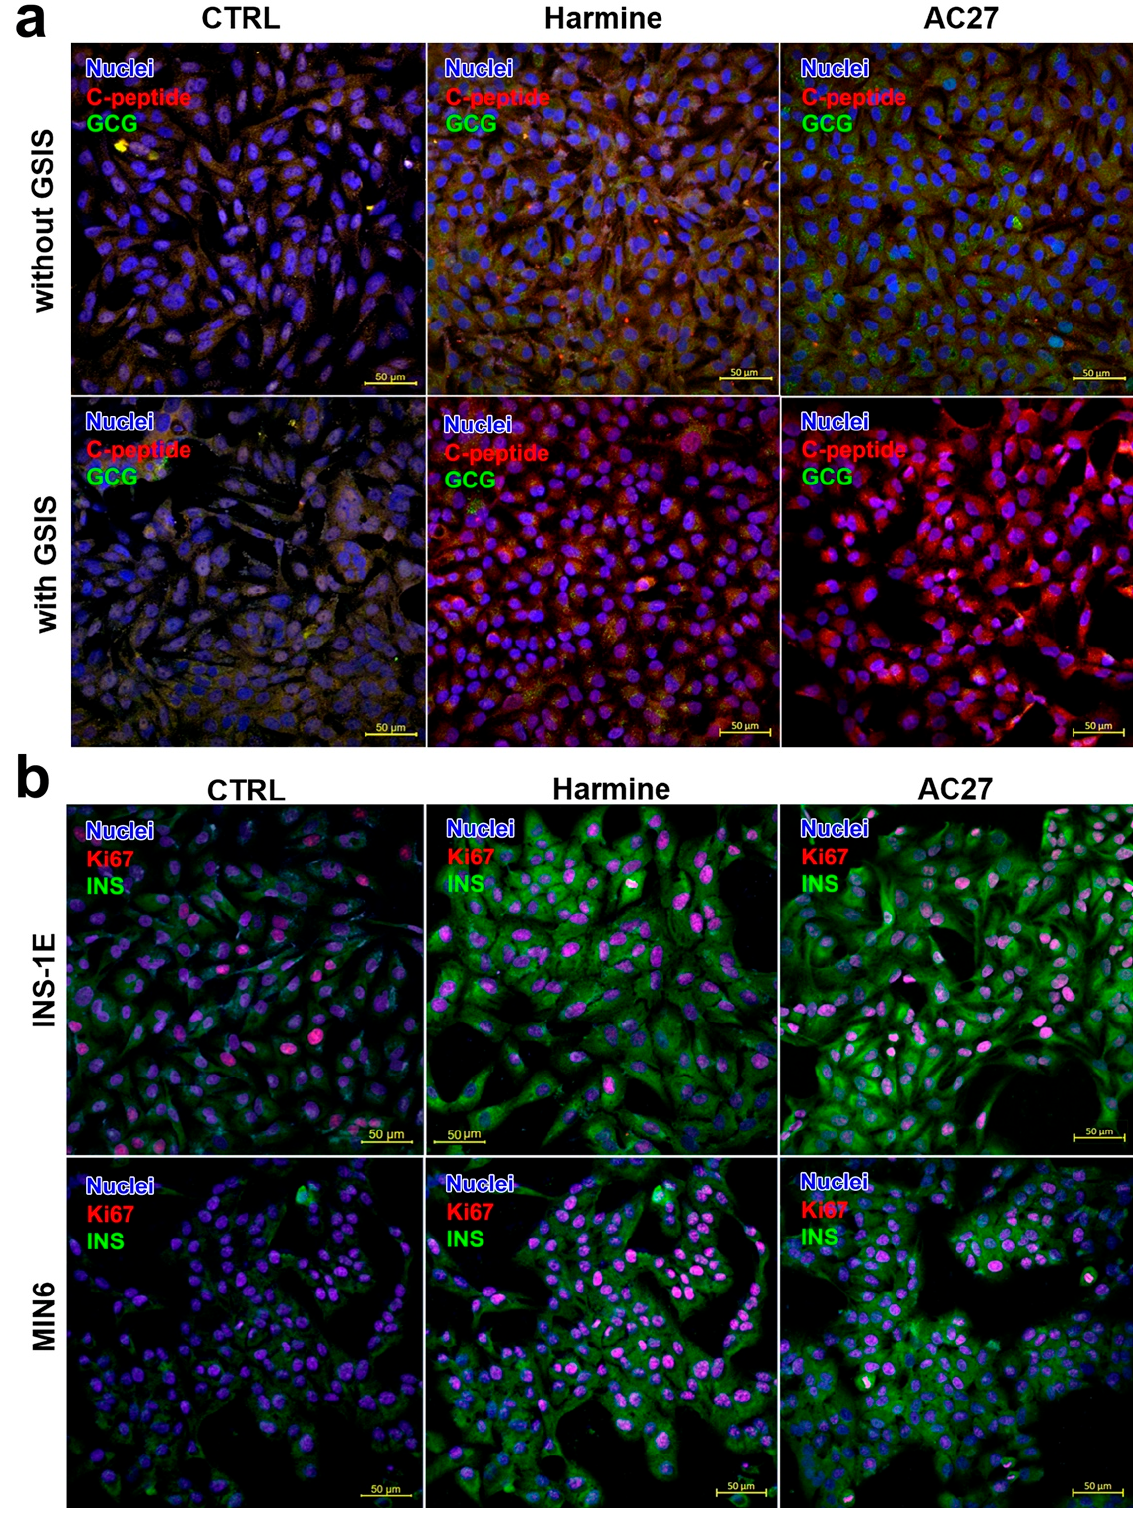
Figure 8. Representative confocal images. ( a ) Proliferation rate (Ki67) and insulin (INS) secretion in INS-1E and MIN6 cells for cells not treated with inhibitor (CTRL), harmine and AC27. ( b ) Expression levels of C-peptide and glucagon (GCG) before and after GSIS. Scale bars, 50 μ m.